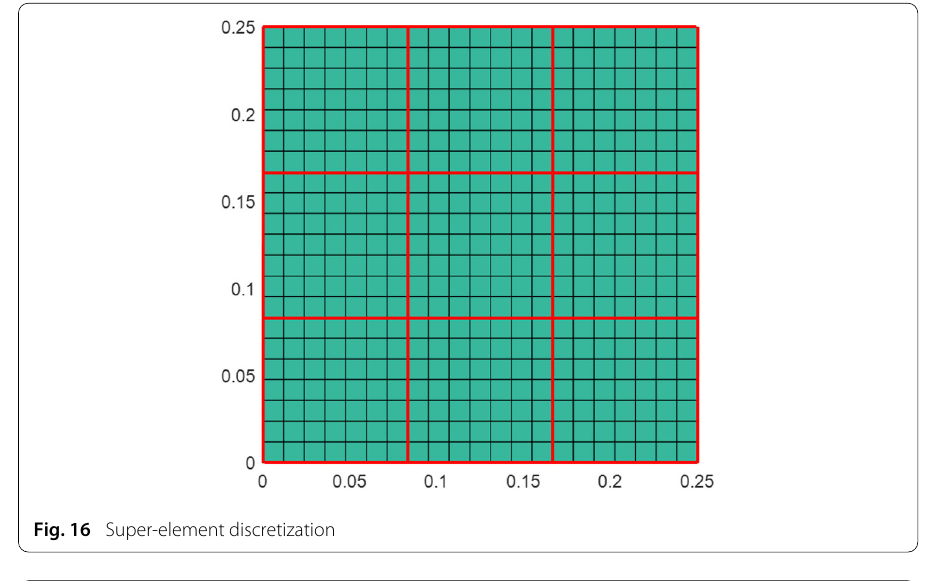
Fig. 16 Super-element discretization